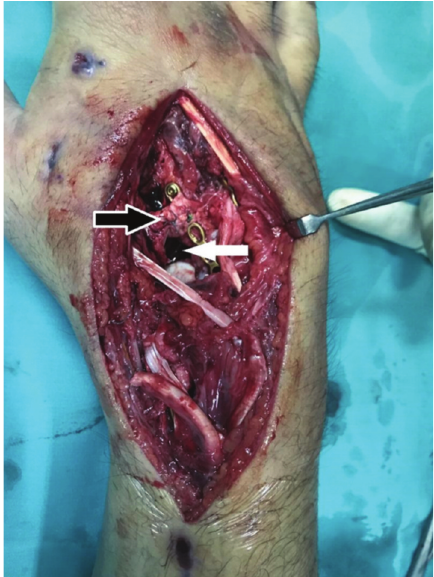
Black arrow shows that the ECRL is folded in anchovy-like Fig. 2: fashion. White arrow shows the void which is to be filled with the folded ECRL.